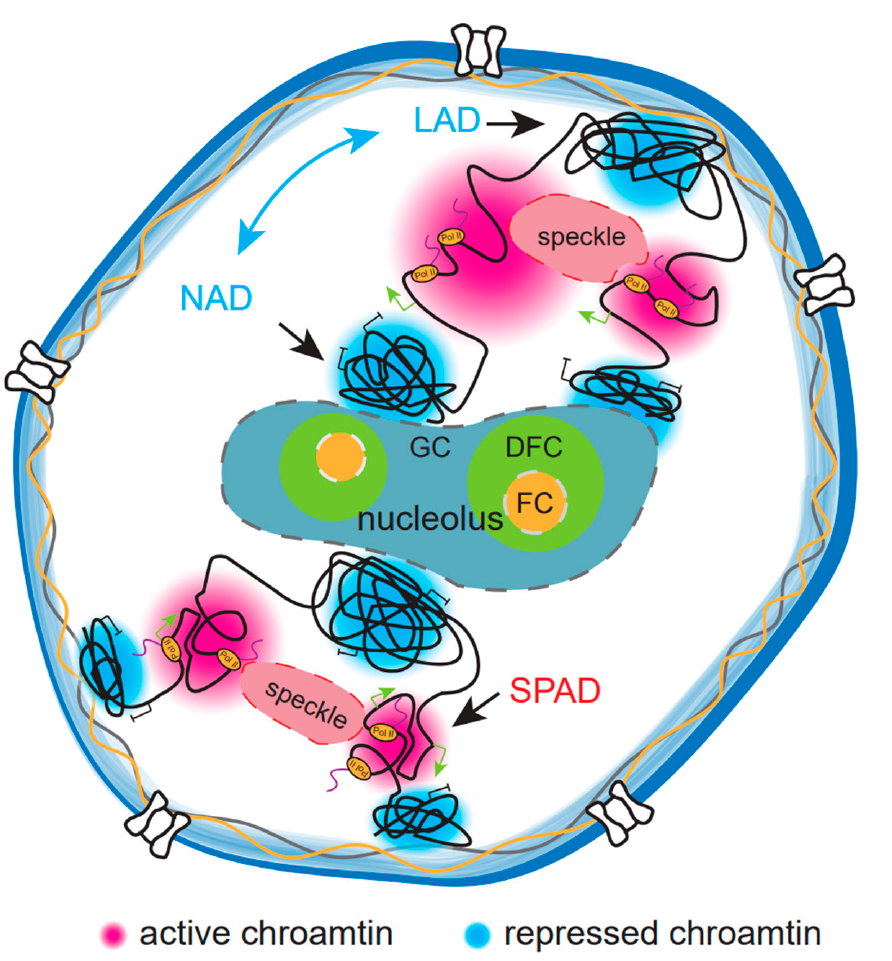
Figure 2. Model for how nuclear sub-compartments shape 3D genome organization. These fixed nuclear elements provide physical limitations for both euchromatin and heterochromatin distribution. As the largest sub-compartment, the nucleolus has three internal phase-separated layers, namely, the fibril center (FC), dense fibrillar component (DFC) and granular component (GC). Transcrip- tionally inactive heterochromatin clusters (blue) formed by LLPS are widely distributed around nucleolus. Nuclear speckle is also formed by LLPS and is the region for pre-mRNA splicing. Speckle- associated domains (SPADs) tend to be transcriptionally active regions with high concentrations of RNA polymerase II (red). Chromatin associated with nuclear lamina also tend to be condensed heterochromatin. The double arrow indicates the relocation between nucleolar-associated domains (NADs) and lamina-associated domains (LADs) after mitosis.